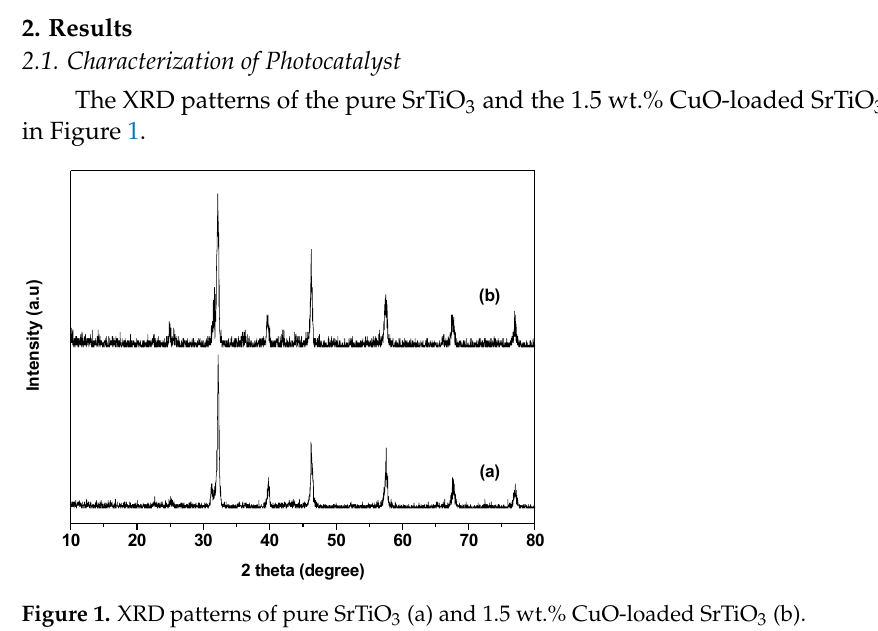
Figure 1. XRD patterns of pure SrTiO 3 ( a ) and 1.5 wt.% CuO ‐ loaded SrTiO 3 ( b ). The result in Figure 1 shows that the X ‐ ray diffraction pattern of the 1.5 wt.% CuO ‐ SrTiO 3 sample almost coincides with that of the pure SrTiO 3 . Diffraction peaks at 32.42°, 39.98°, 46.48°, 57.79°, 67.80° and 77.17° in all of XRD patterns are corresponded to the (110), (111), (200), (211), (220) and (310) planes of cubic SrTiO 3 (JCPDS card No. 35 ‐ 0734) [31], respectively. This result indicates that the obtained SrTiO 3 possesses pure cubic phase. The phase of CuO cocatalyst is not observed in the XRD pattern of the 1.5 wt.% CuO ‐ SrTiO 3 .